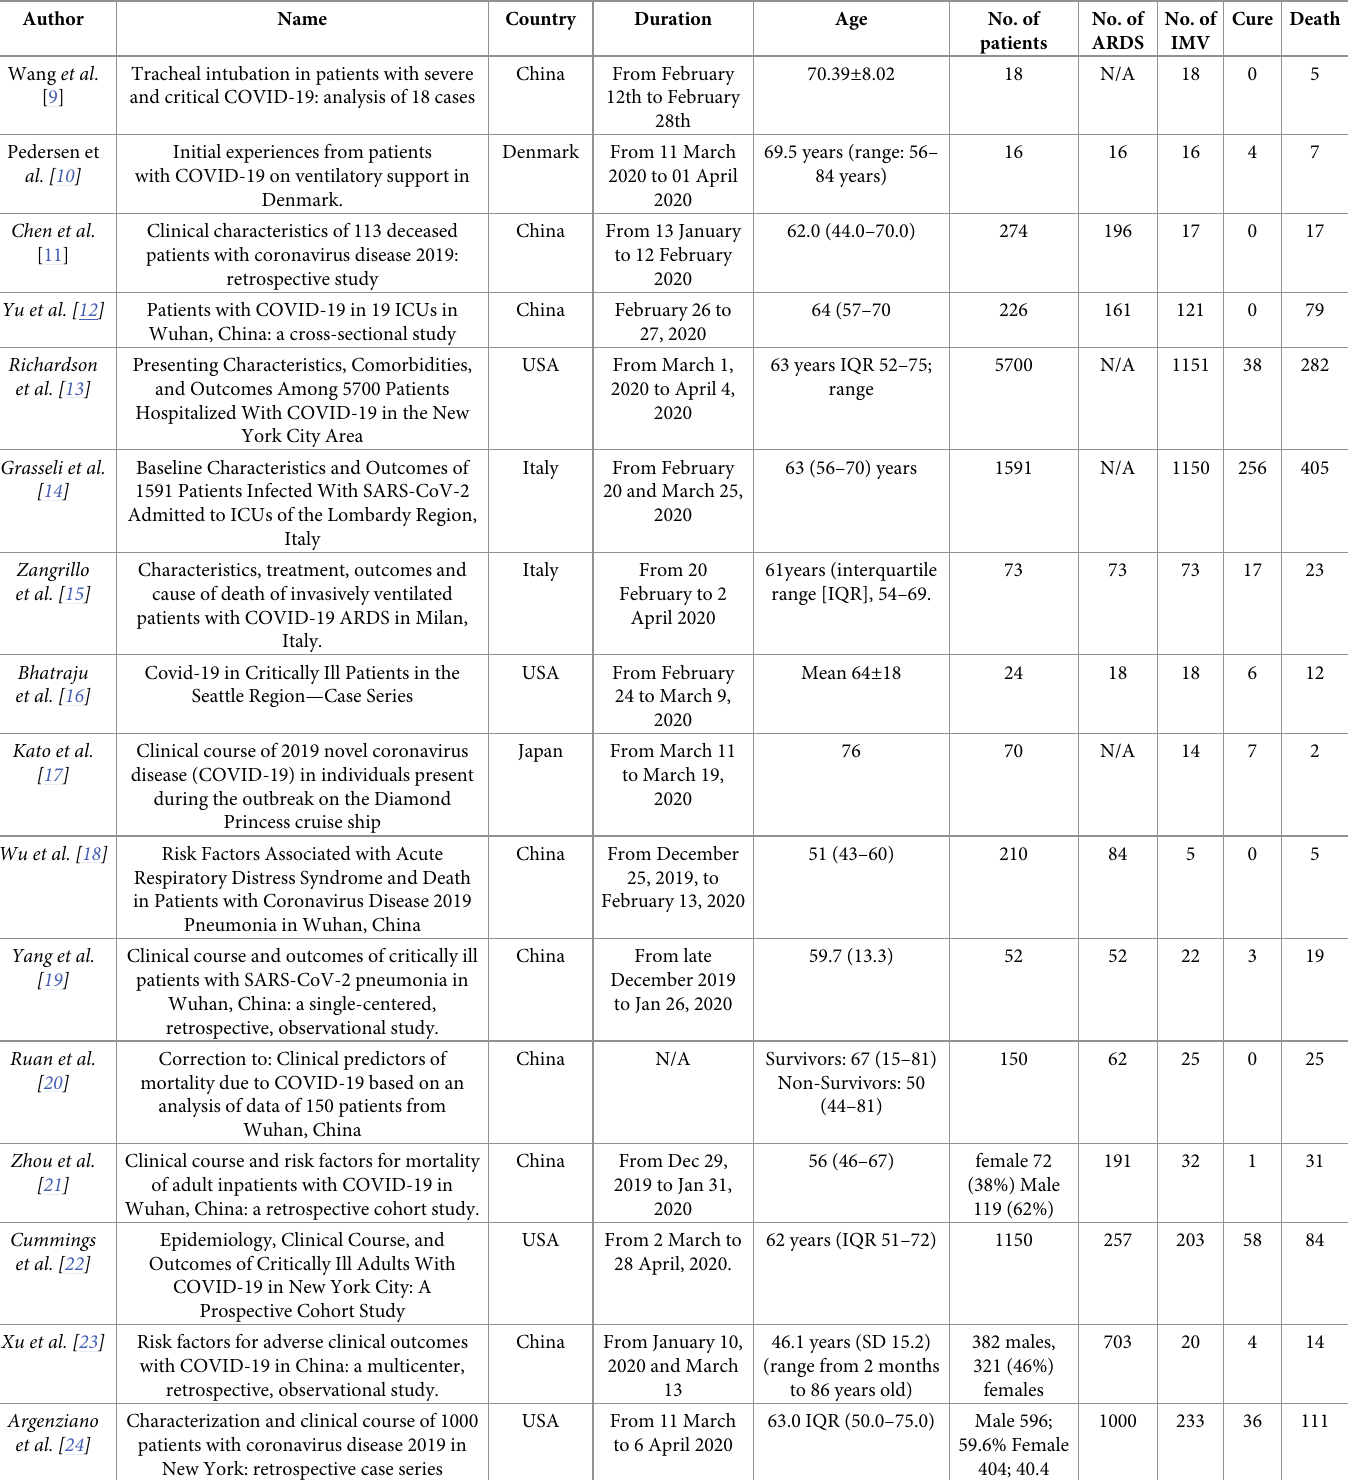
Table 1. All studies included in the